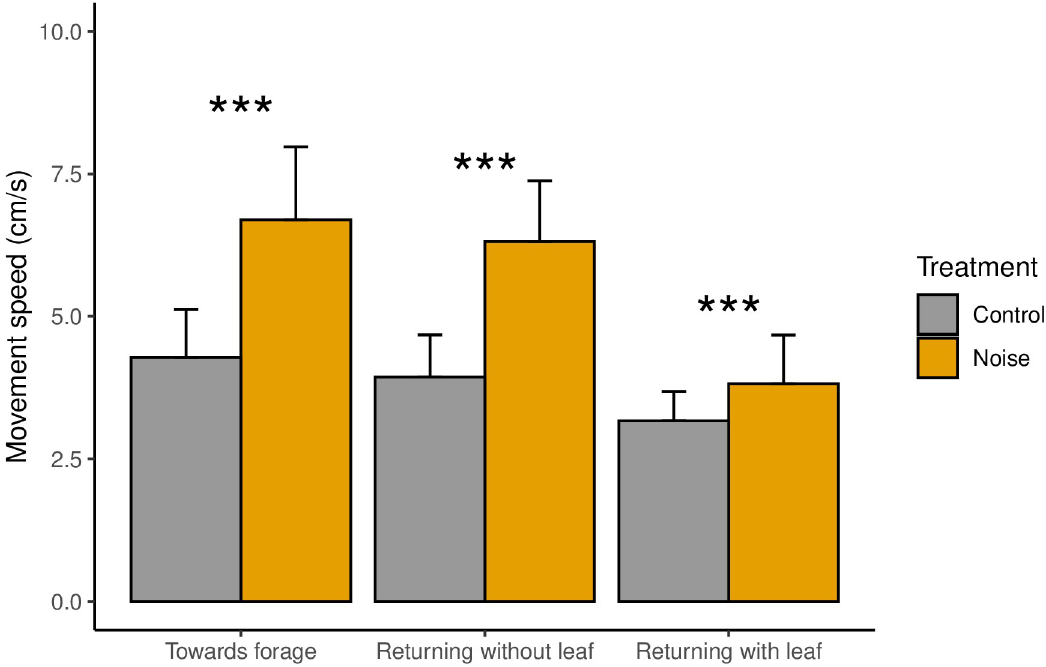
Fig 1. Mean ( ± SD) straight-line movement speed for three foraging ant behaviours for noise and control treatments. Stars indicate test significance level for pairwise testing between control and noise treatment for each foraging behaviour ( ��� = P < 0.001).